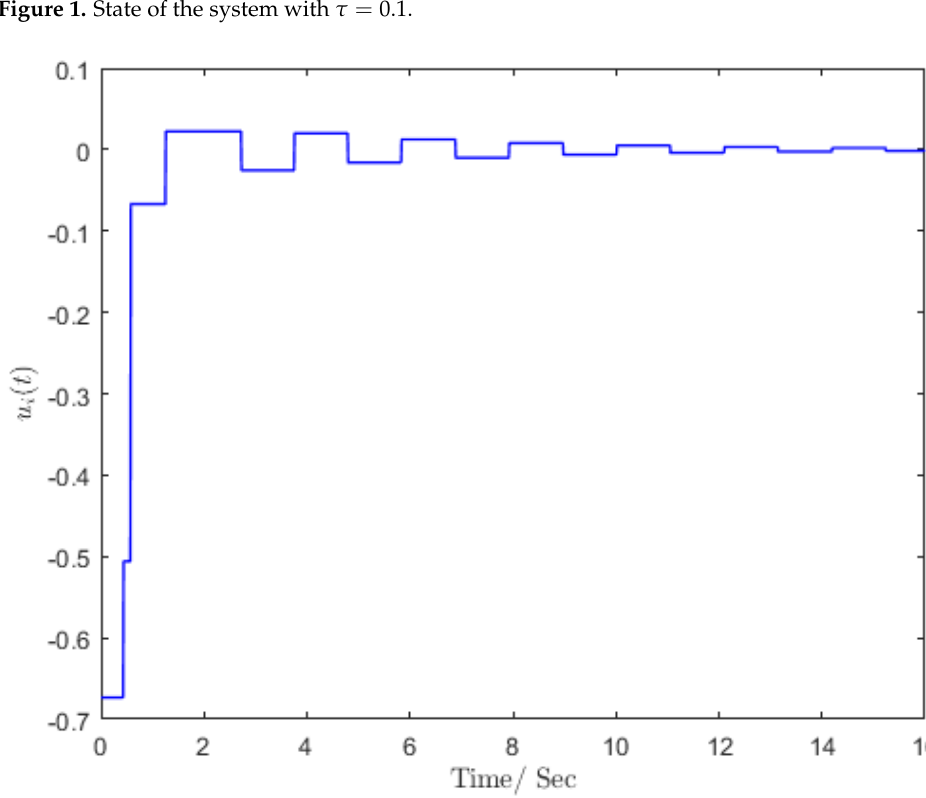
Figure 2. Controller with event–triggered impulse and τ =